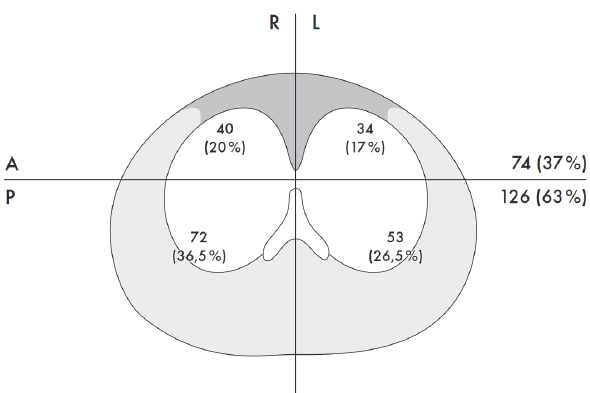
Fig. 3. Location of index tumour in individual